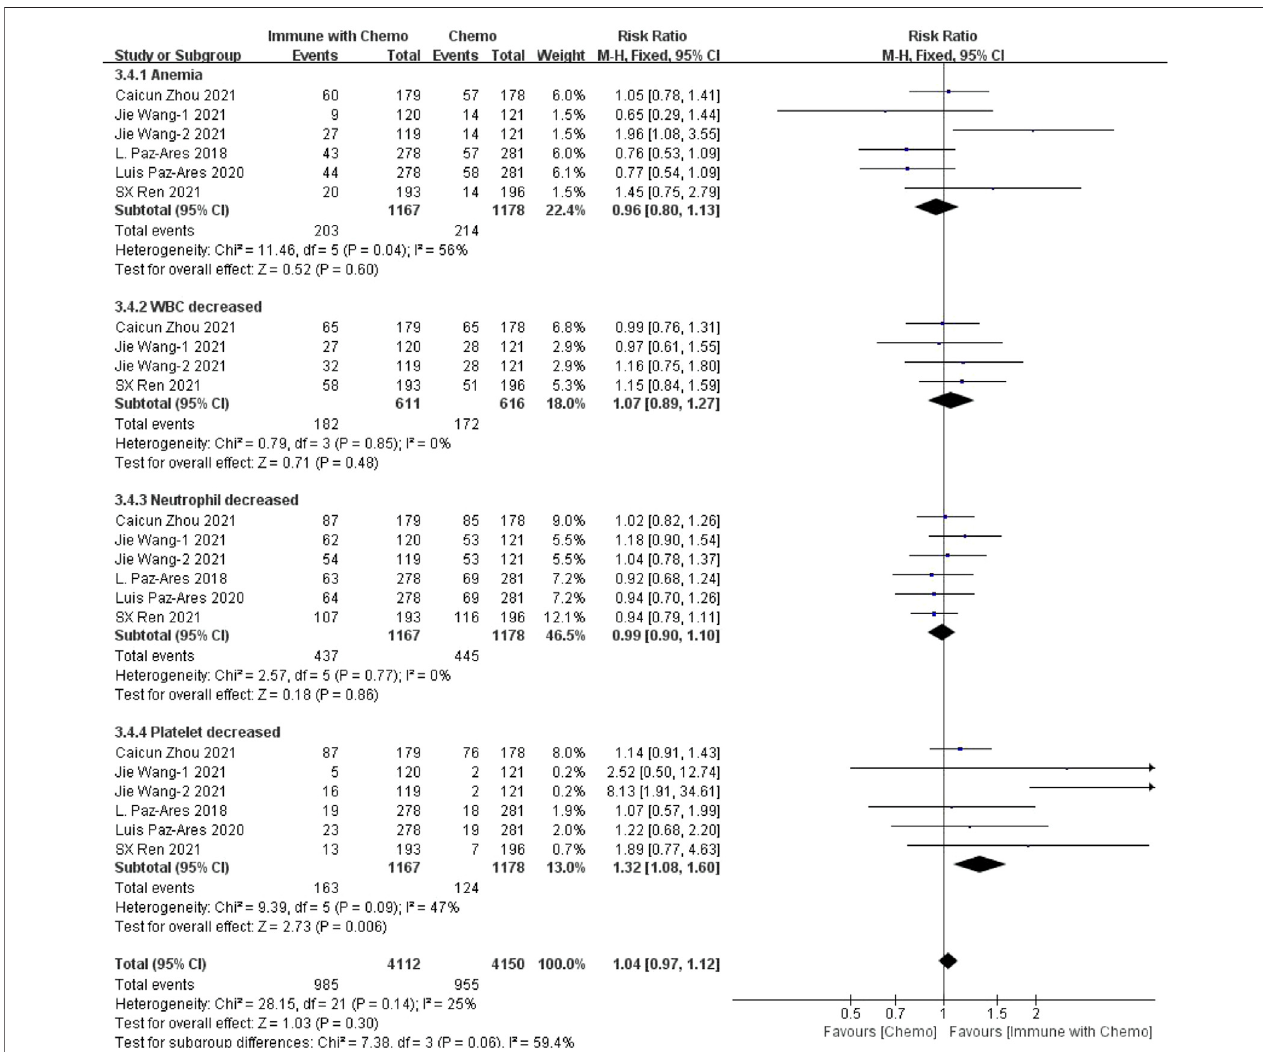
FIGURE 6 | Meta-analysis results of adverse reactions above grade 3 in hematological toxicity between the chemo with immune group and chemo group.